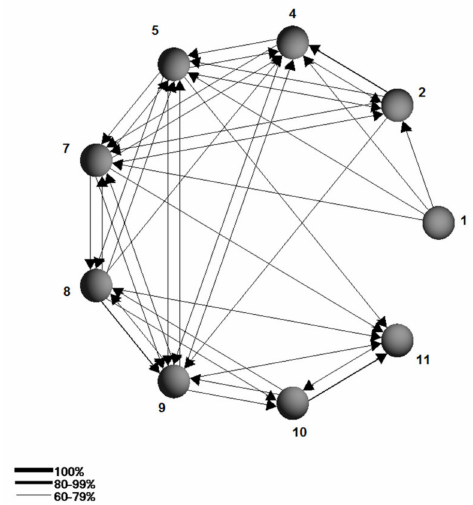
Figure 9. Oriented multigraph of binary relations, built on an array of descriptions of long-term species composition of the Ob River zooplankton in the studied sites (sites numbers correspond to those specified in Table